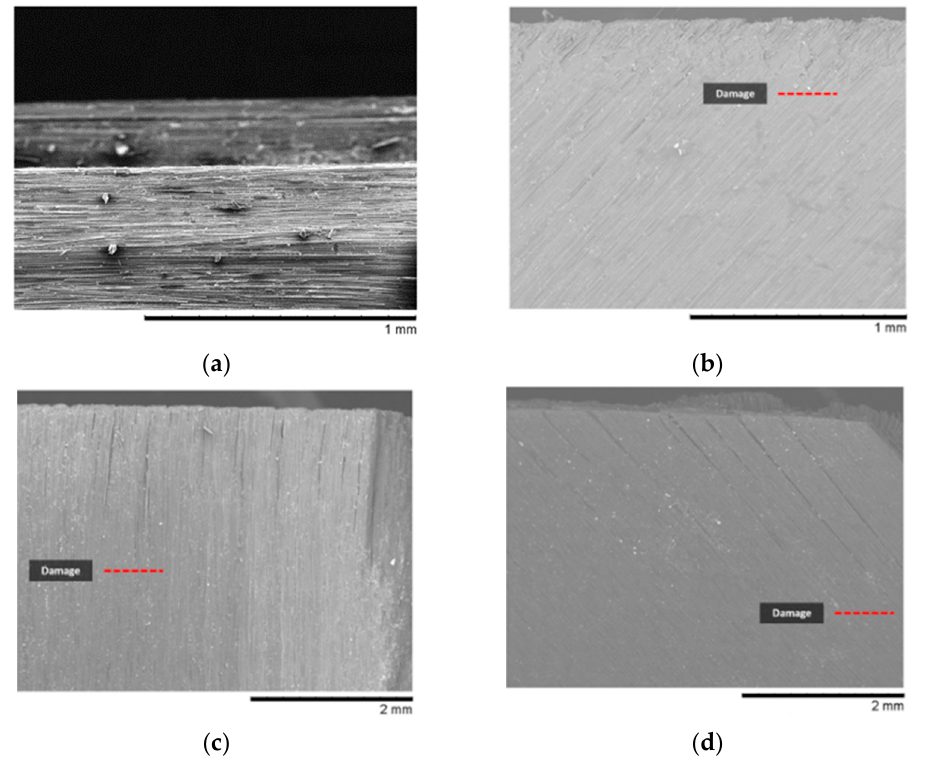
Figure 14. Damage in machined workpiece for depth of cut 50 µ m and fibre orientation ( a ) θ = 0°, ( b )